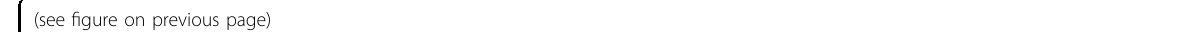
Fig. 6 Lipin-1 regulates UVB-induced NF- ĸ B phosphorylation, which might be mediated by FFA levels. a NHEKs that were transfected with the vector containing lipin-1 cDNA or pCMV-AC empty vector were exposed to 20 mJ/cm 2 UVB and cultured for 24 h. Immunoblot analysis was used to determine p-NF- ĸ B p65 (Ser536) and NF- ĸ B p65 expression levels in cell lysates. The levels of phosphorylated NF- ĸ B p65 (Ser536) were normalized to p65 NF- ĸ B. b NHEKs that were transfected with lipin-1 or control siRNA were exposed to 20 mJ/cm 2 UVB and cultured for 24 h. Immunoblot analysis was used to determine p-NF- ĸ B p65 (Ser536) and NF- ĸ B p65 expression levels in cell lysates. The levels of phosphorylated NF- ĸ B p65 (Ser536) were normalized to p65 NF- ĸ B. c , d Total lipids were extracted from cells, and biochemical analysis was used to determine the TAG, FFA and PA levels. PDE activity was assayed in cell lysates. e Total RNA was extracted, and the relative mRNA levels of ATGL and HSL were measured via qRT-PCR. f NHEKs were transfected with lipin-1 siRNA or control siRNA for 24 h, exposed to 20 mJ/cm 2 UVB radiation, and incubated in the presence of C75 (5 μ M) for 24 h. Immunoblot analysis was used to determine p-NF- ĸ B p65 (Ser536) and NF- ĸ B p65 expression levels in cell lysates. The levels of phosphorylated NF- ĸ B p65 (Ser536) were normalized to NF- ĸ B p65. All data (mean ± SD) represent three independent experiments. Means without a common letter differ; P <